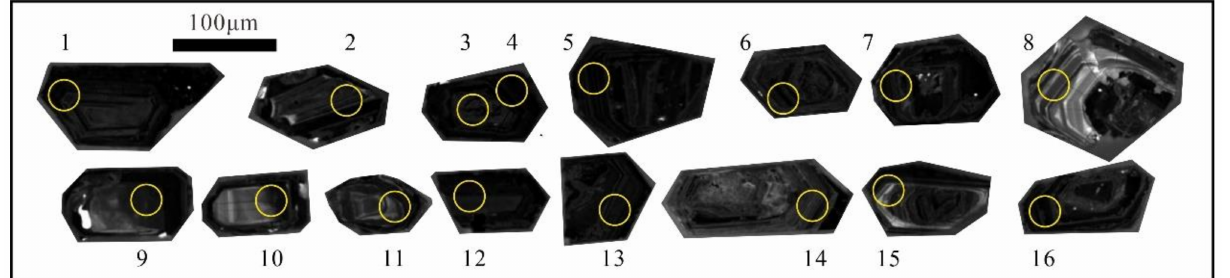
Figure 4. CL images for zircons from LG. The circles and numbers represent the positions and numbers of the laser ablation points for zircon U-Pb dating,